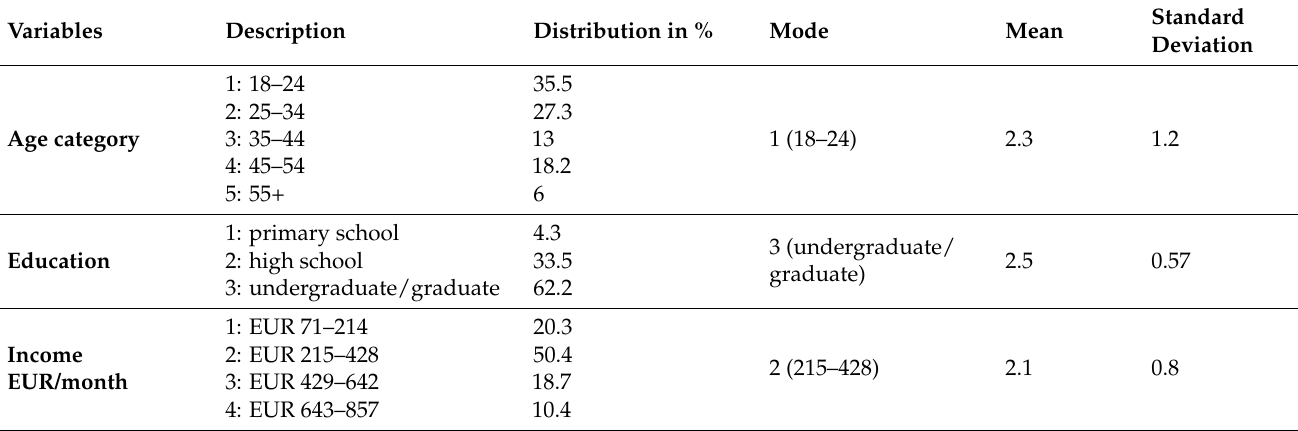
Table 1. Characteristics of the